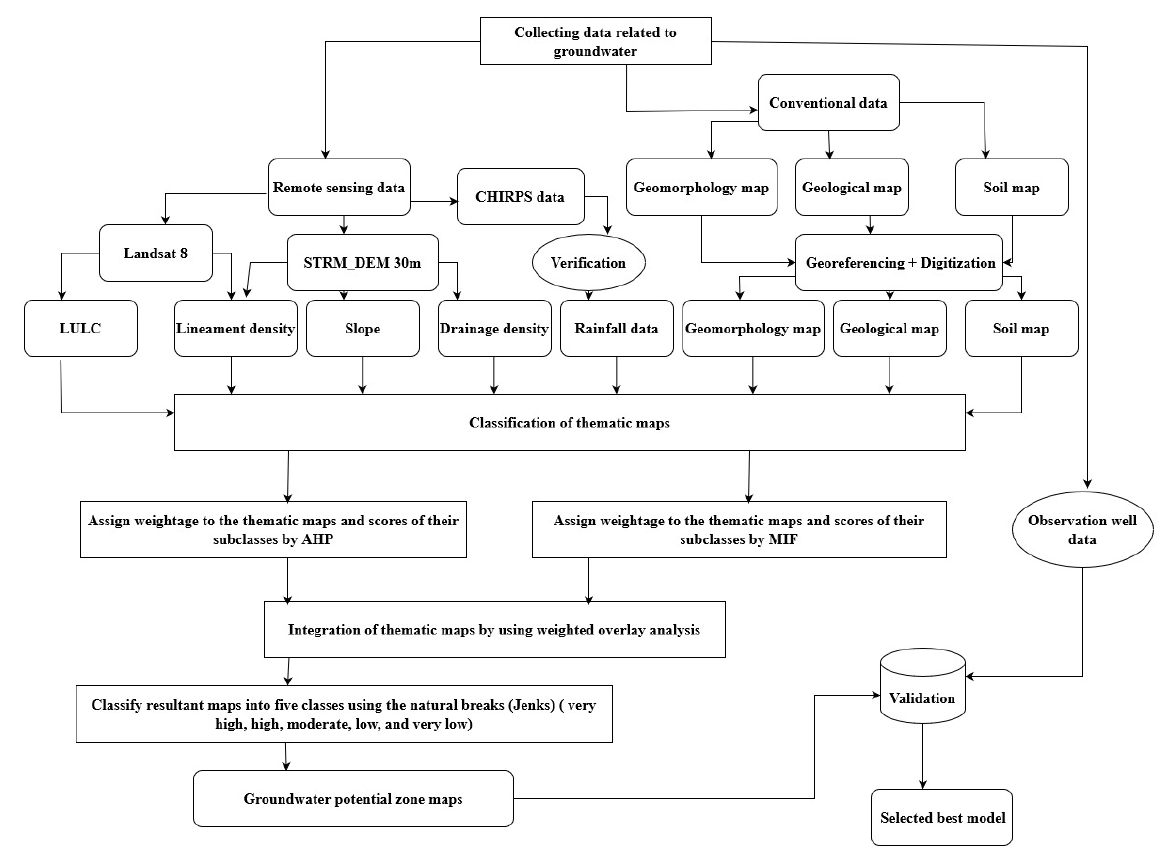
Figure 4. Flow chart of the methodology used to select the best model.